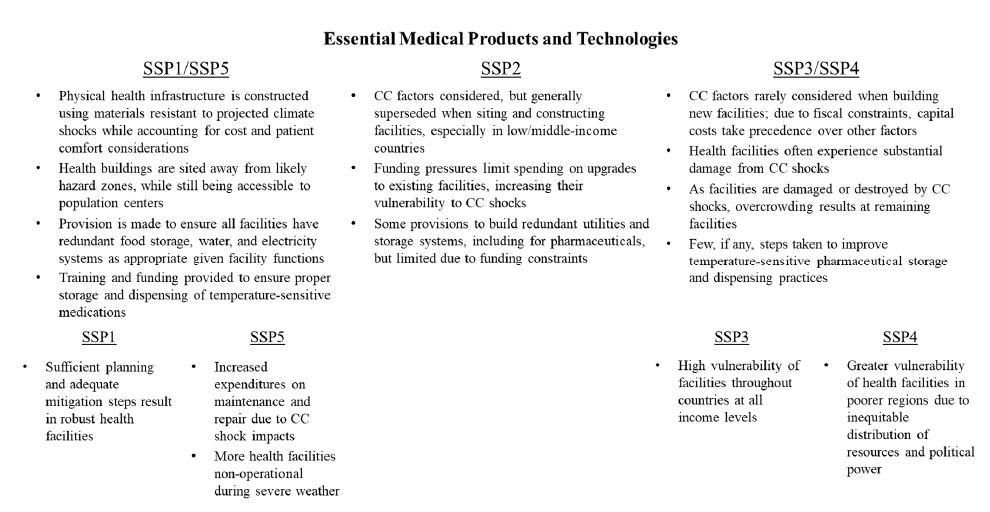
Figure 6. Variation in essential medical products and technologies across SSPs.